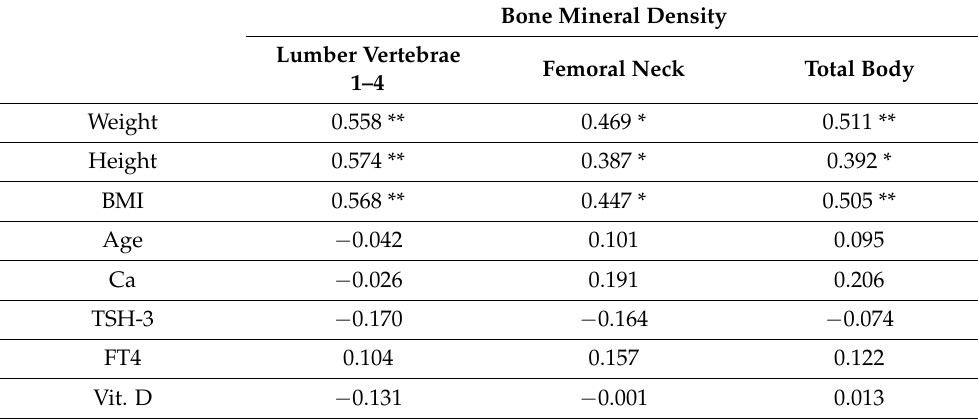
Table 4. Correlation matrix between bone menial density Z-score, sample characteristics, and labora- tory